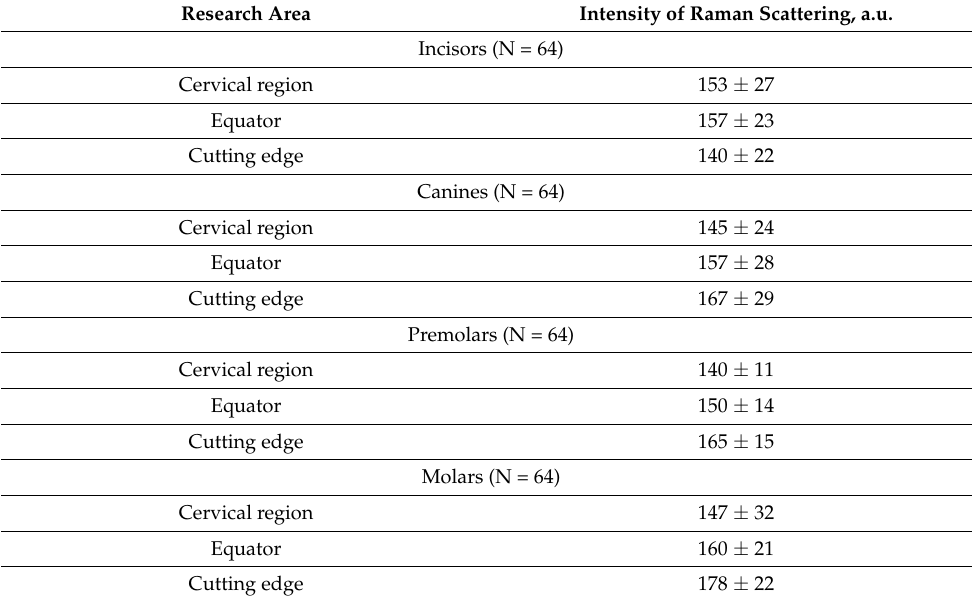
Table 4. The intensity of Raman scattering on different teeth of patients depending on the measure- ment